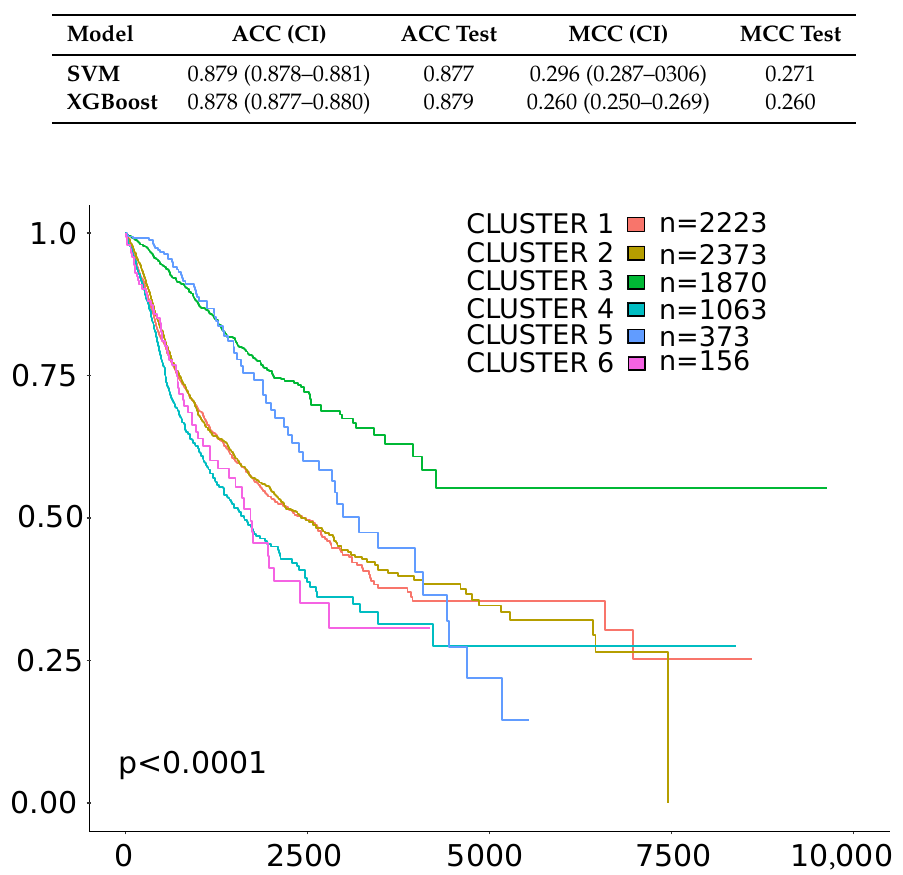
Table 4. Model metrics in cross-validation (mean with confidence intervals) and on the test set. ACC: